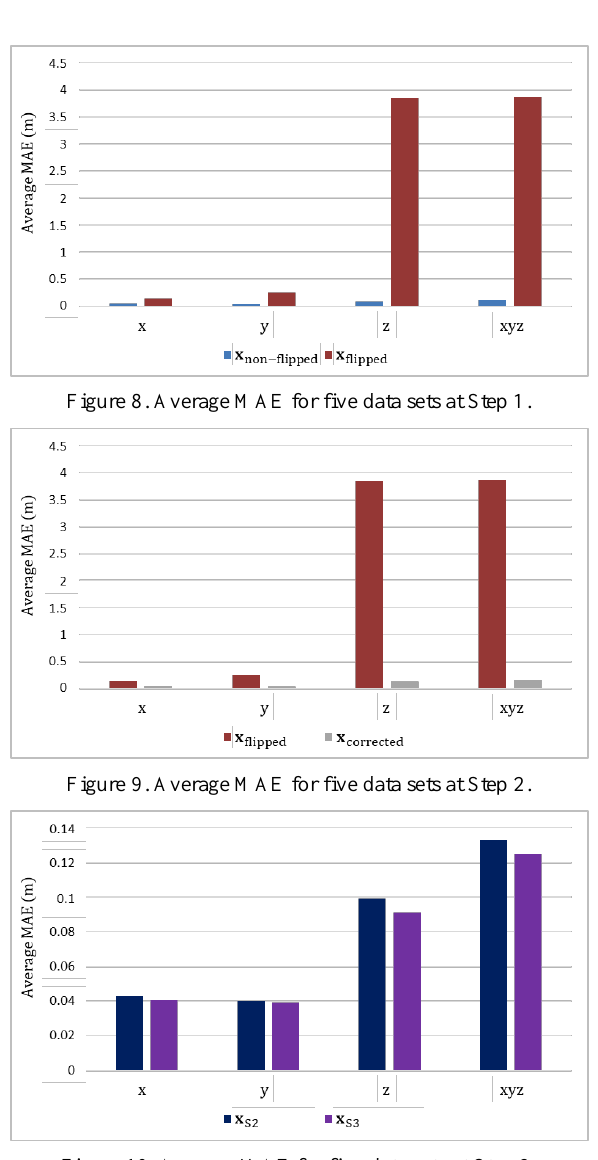
Figure 10. Average MAE for five data sets at Step